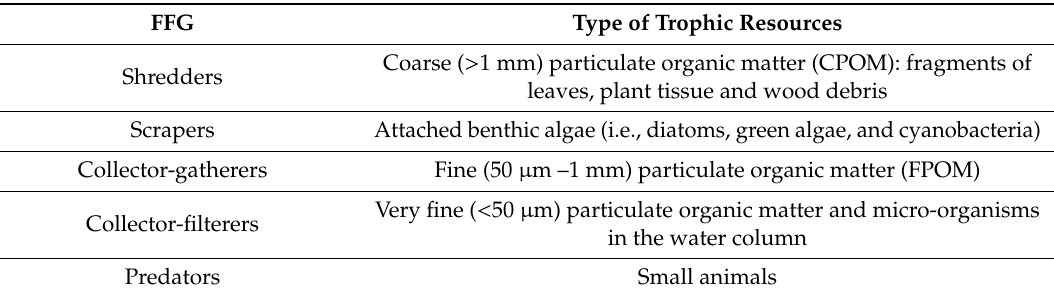
Table 1. Classification of the functional feeding groups